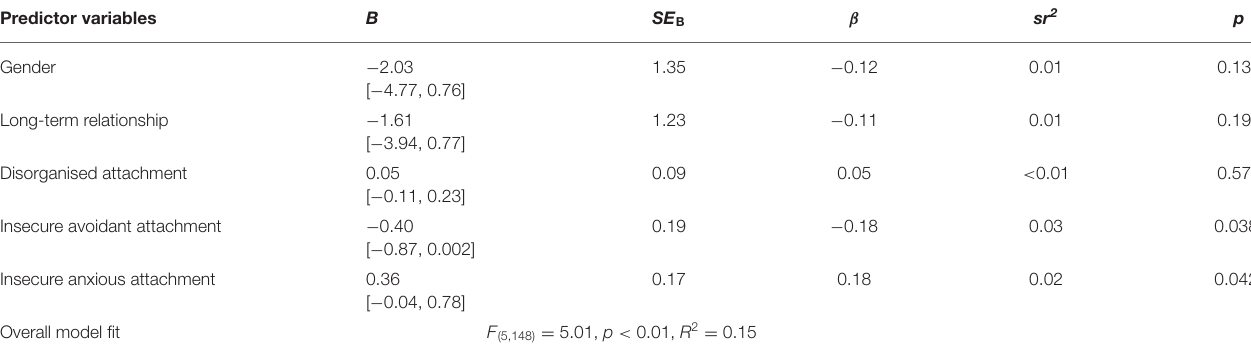
TABLE 4 | Summary of multiple regression analysis predicting compulsive